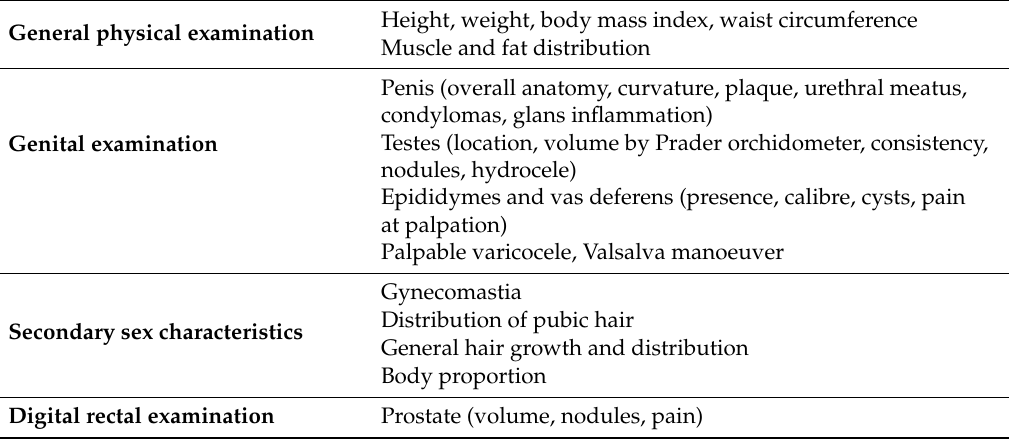
Table 3. Scheme of physical examination for an infertile